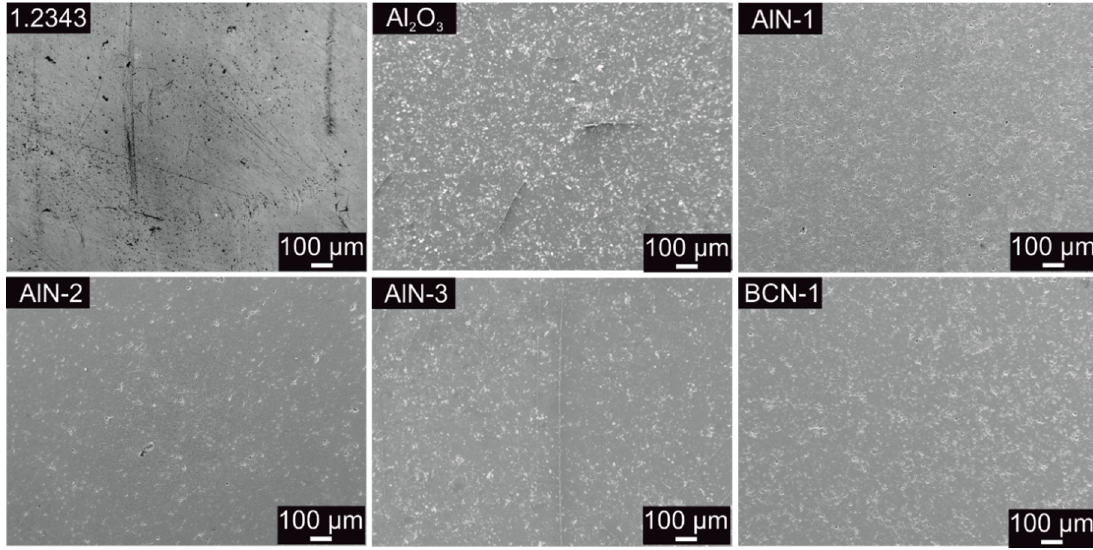
Figure 7. SEM images of the different surfaces after the Ball-on-Disc experiments at 153 °C.